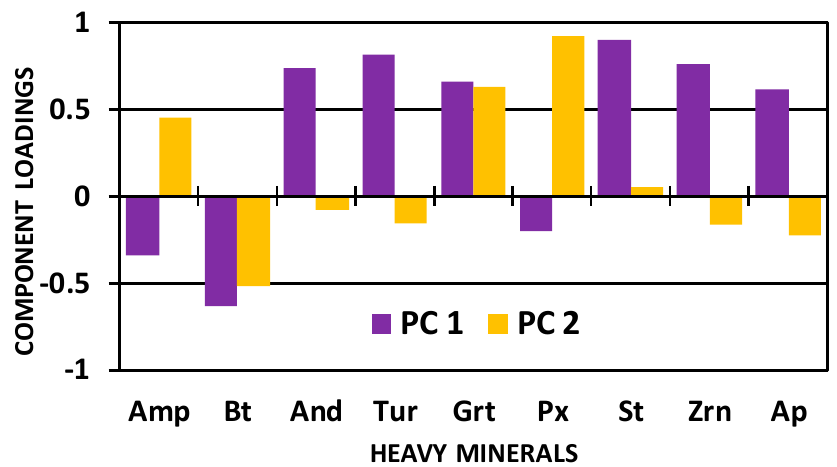
Figure 8. Mineral loadings according to the first (PC1) and second (PC2) components accounting for about 65% of variance. Amphibole (Amp), biotite (Bt), andalusite (And), tourmaline (Tur), garnet (Grt), pyroxene (Px), staurolite (St), zircon (Zrn), and apatite (Ap).